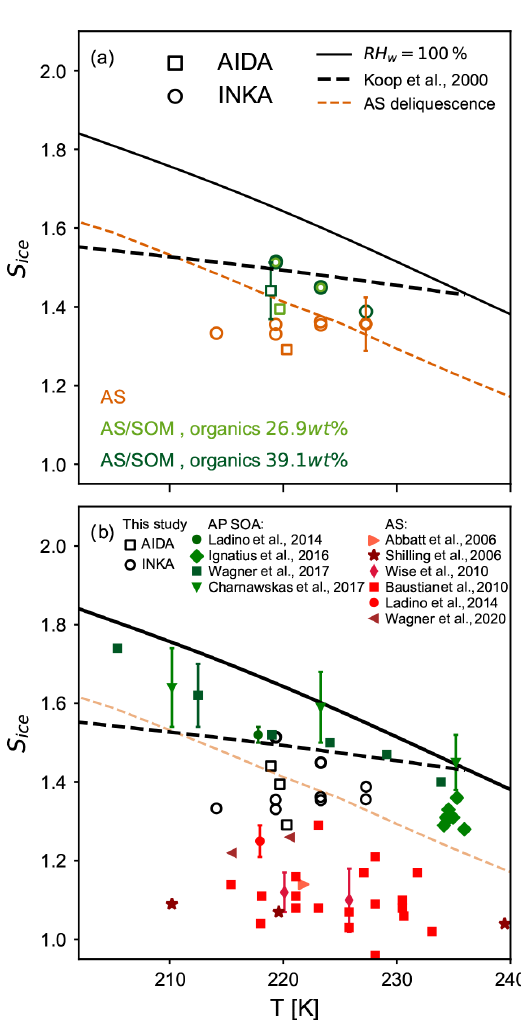
Figure 5. Summary of the ice nucleation onsets for crystalline am- monium sulfate (AS), pure secondary organic aerosol (SOA) par- ticles, and crystalline AS coated with secondary organic matter as a function of temperature T . The solid black line indicates water saturation (RH w = 100%), the dashed black line indicates the ho- mogeneous freezing threshold ( (cid:49)a w = 0 . 3, Koop et al., 2000), and the dashed orange line is the ammonium sulfate deliquescence rela- tive humidity (Clegg et al., 1998). (a) Results from this study (cor- responding to an ice-nucleating fraction of 0.1%) for pure, crys- talline AS (orange symbols) and for AS coated with α -pinene SOM (green symbols). Light green symbols refer to experiment B1 (or- ganic mass fraction 26.9wt%), and dark green symbols refer to ex- periment B2 (organic mass fraction 39.1wt%). Results from the AIDA expansion cooling experiments are reported with squares, and circles refer to INKA results. (b) Results from this study (open symbols) are compared to literature data for crystalline AS (red symbols) and α -pinene SOA particles (green symbols).